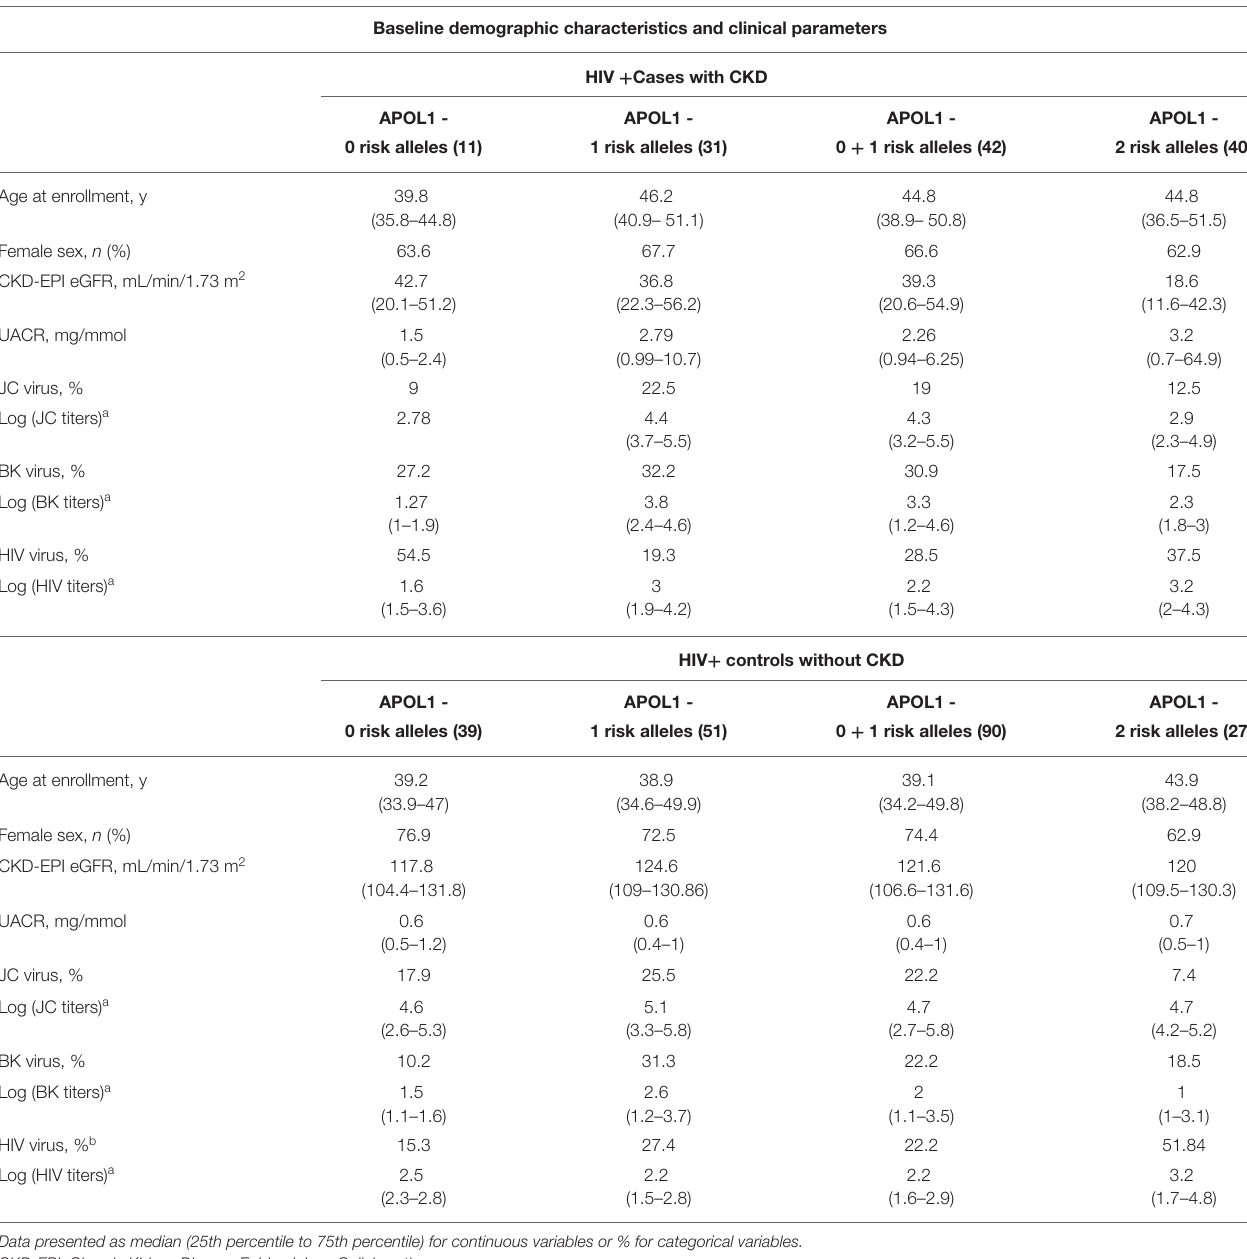
TABLE 2 | Demographic and clinical characteristics for individuals participating in this cohort, stratified by case-control status. Baseline demographic characteristics and clinical